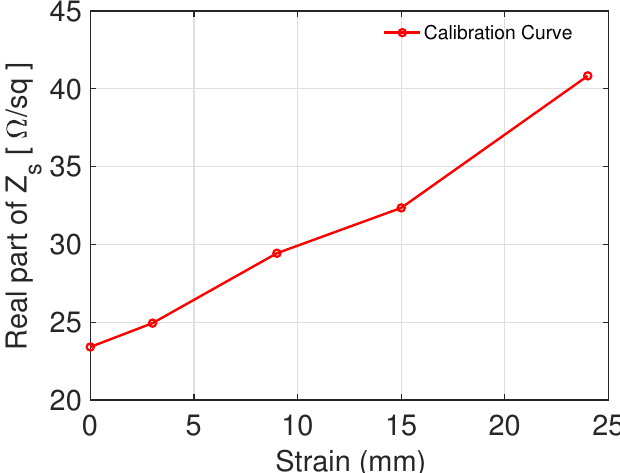
Figure 8. Calibration curve for the material under